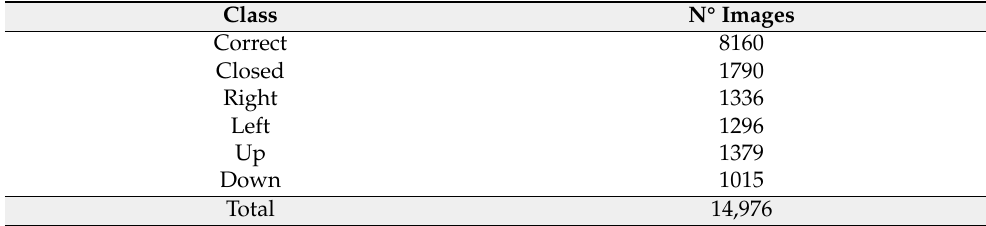
Table 2. PopEYE dataset composition across the six different annotated classes.